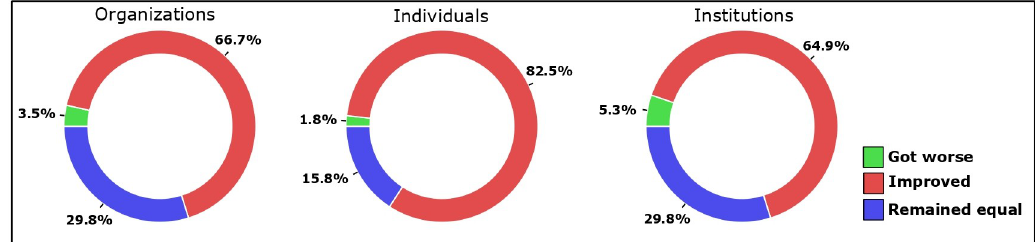
Fig 3. Social results of restoration. The chart shows the percentage of projects where an improvement, a setback or a similar collaboration was perceived in ecological restoration actions among non-governmental organizations, individuals and scientific or educational institutions. The total number of projects analyzed was 57.